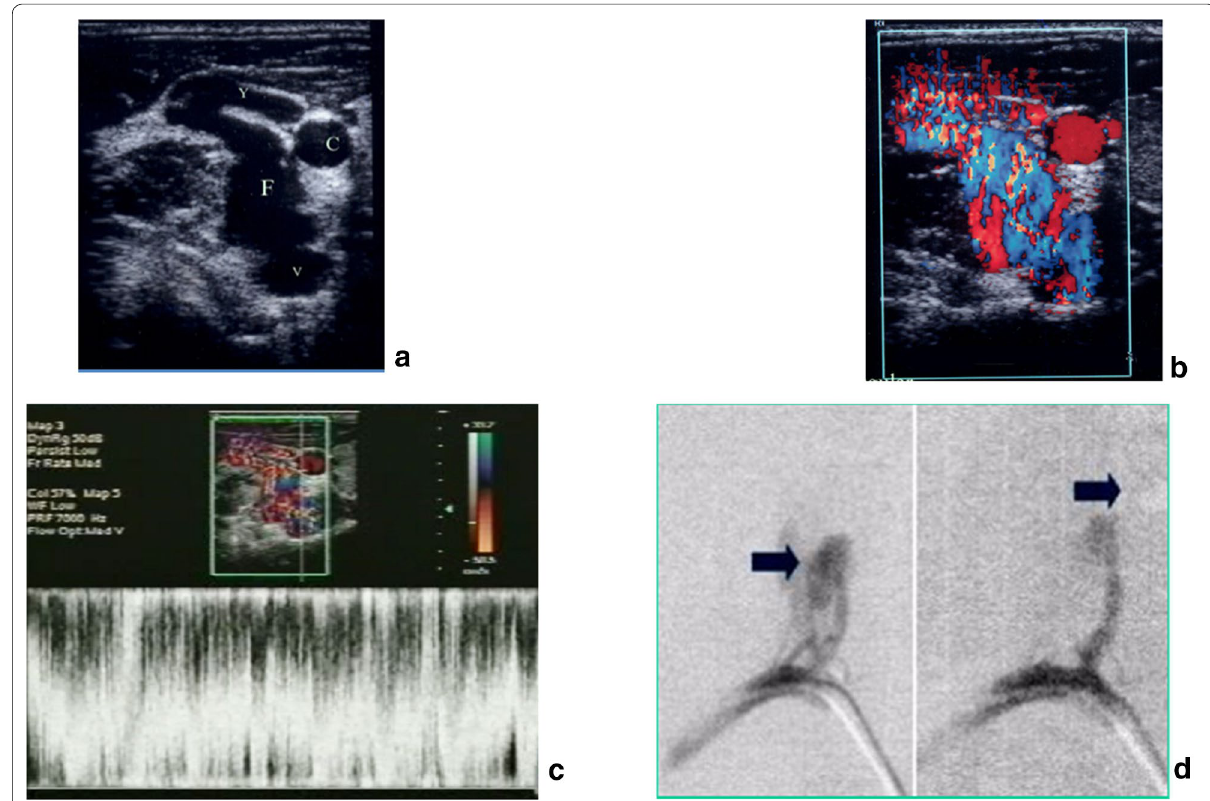
Fig. 18 Arterio venous fistula: gun shot wound in the right side of the neck. Arteriovenous traumatic fistula between right yugular vein and right vertebral artery. a B mode: anechoic image connecting right yugular vein with the right vertebral artery. C carotid artery, V vertebral artery, Y yugu- lar vein, F fistula. b Color Doppler: mosaic of colours representing different velocities. Color in soft tissues surrounding the FAV representing the thrill. c Pulse Doppler: spectral analysis with hight velocities spectrum and turbulent flow. d Angiographic findings